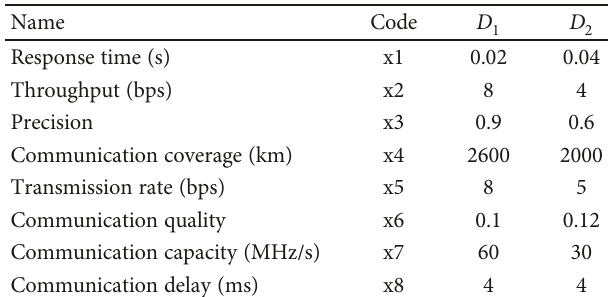
Table 2: Tactical indexes of S . Table 3: Tactical indexes of D